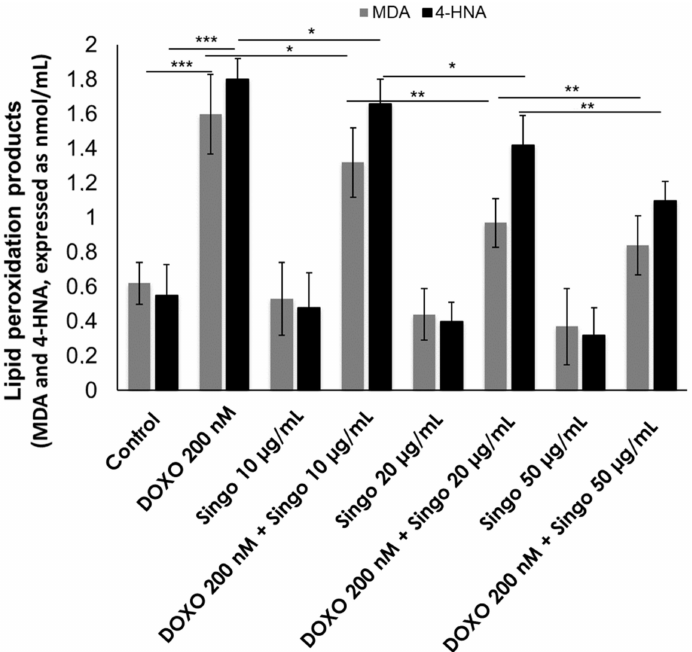
Figure 11. Lipid peroxidation products (MDA and 4HNA) expressed as nmol/mL were quantified in human cardiac cells unexposed (control) or exposed to DOXO (200 nM), Singo (10, 25 and 50 µ g/mL) or both in combination for 24 h. Results: mean +/ − SD. *** p < 0.001. ** p < 0.01. * p <